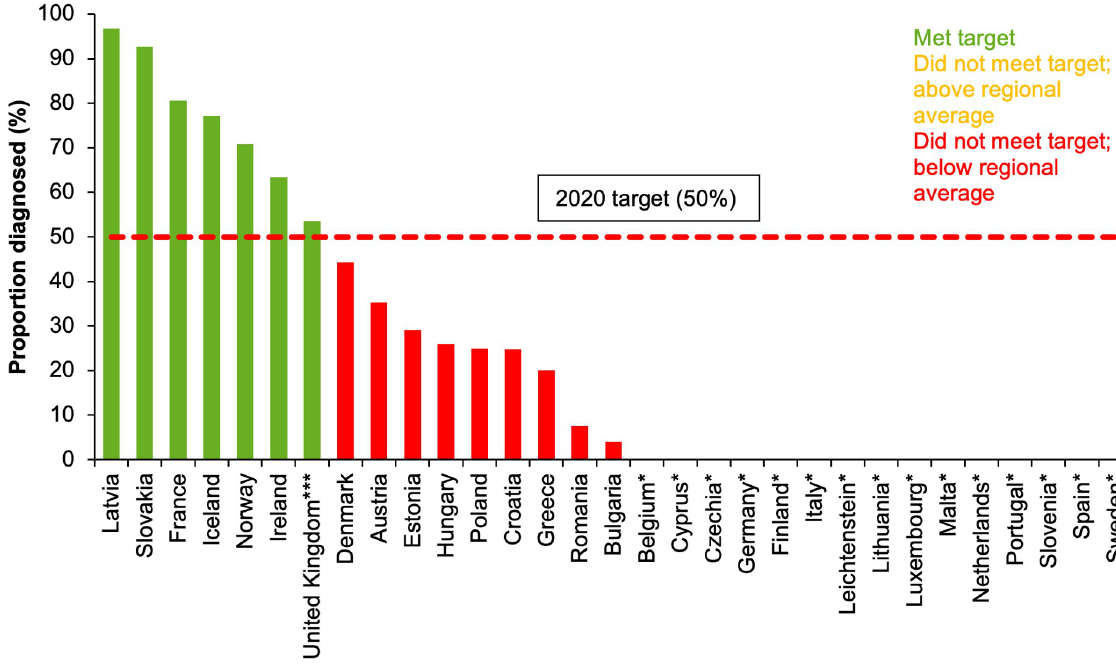
Fig 5. Proportion (%) of people living with chronic HCV infection who had been diagnosed in EU/EEA countries �� , 2017 � [8]. � No data from Belgium, Cyprus, Czechia, Germany, Finland, Italy, Liechtenstein, Lithuania, Luxembourg, Malta, the Netherlands, Portugal, Slovenia, Spain, Sweden. �� Data incomplete on diagnosed cases from Austria (data from 2009), Bulgaria (data from 2016), Estonia (data from 2004) and Spain (data from 2015). For some countries data include cured/spontaneously resolved cases. ��� Data represent England and